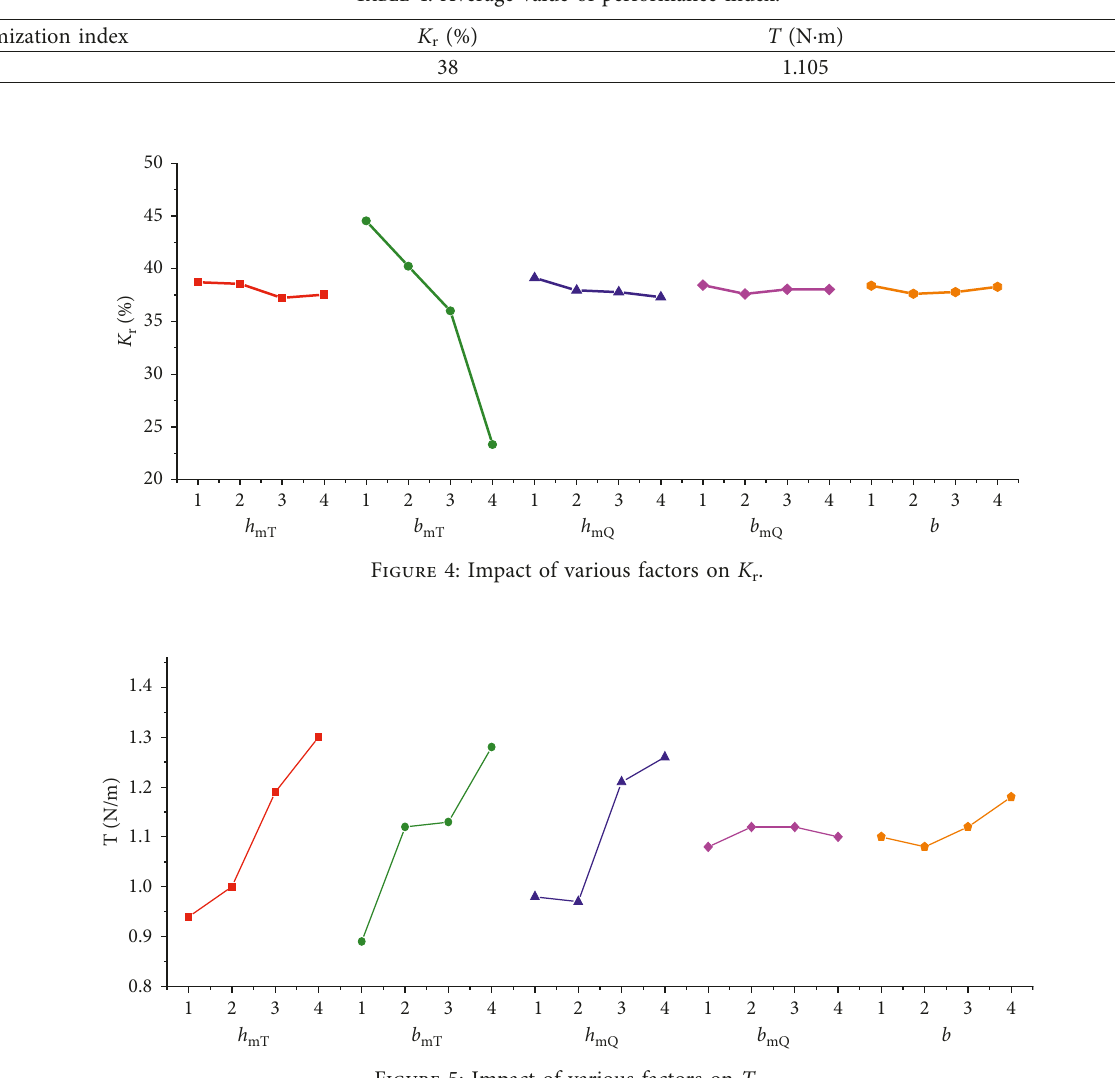
Figure 5: Impact of various factors on T